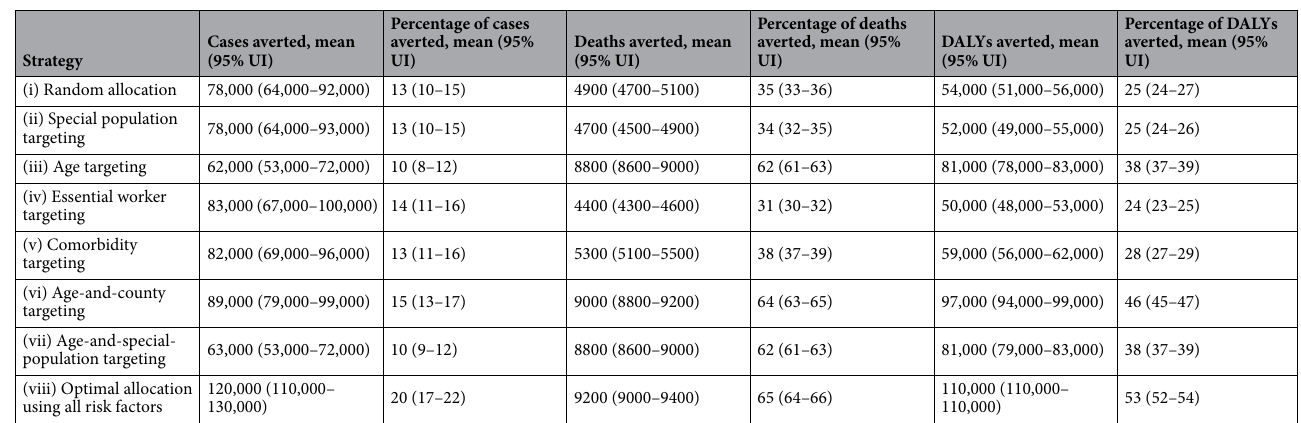
Table 1. Simulated impact of different COVID-19 vaccine prioritization strategies in California on numbers of averted COVID-19 clinical cases, deaths and DALYs for 5 million people vaccinated. Base case analysis simulated vaccine impact over 6 months for 5 million individuals fully vaccinated (2 doses). All strategies assumed that all healthcare workers and long-term care facility residents (skilled nursing facility and assisted living facility residents) were vaccinated first as per the US CDC recommendation 11 . Results for 2 million and 10 million individuals vaccinated are given in Tables S7 and